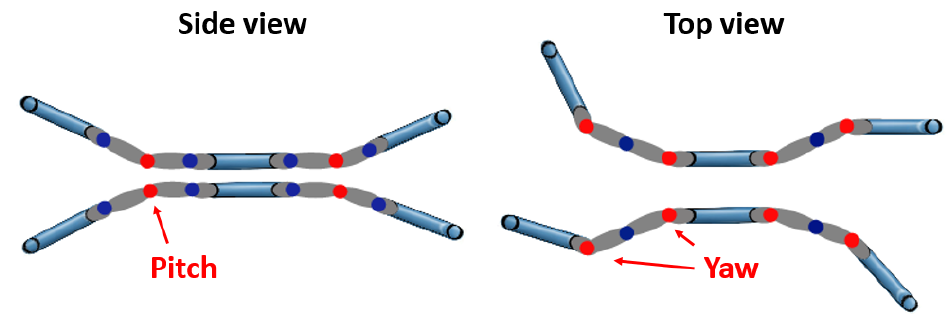
Figure 16. Illustration of the active joints in side-view and top-view, allowing for abdominal wall curve fitting and procedural setup adjustments, respectively.